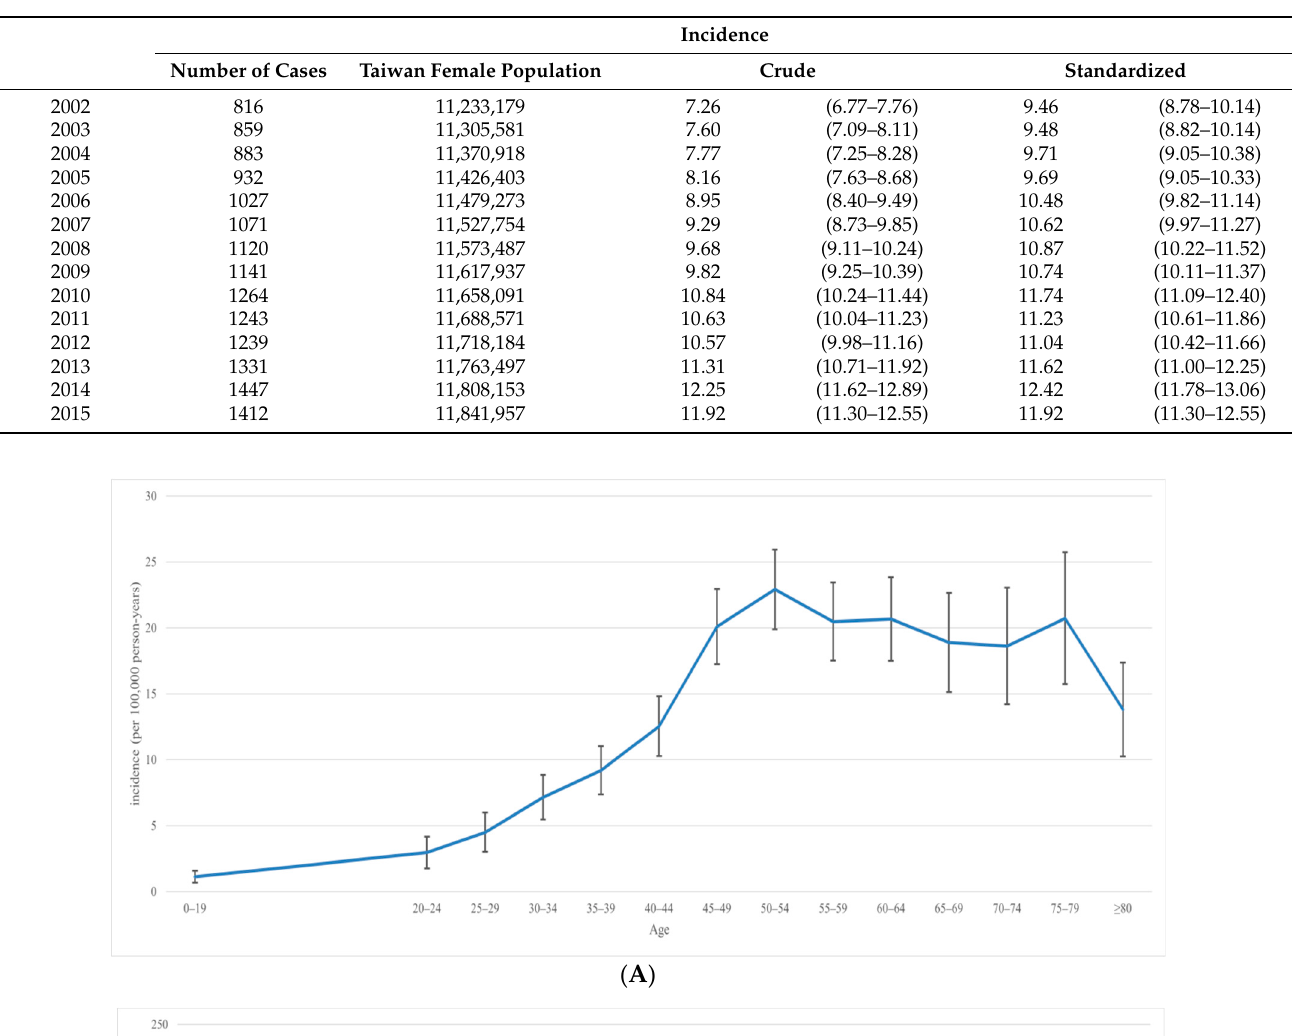
Table 3. Crude and age-standardized incidence (per 100,000 person-years) of ovarian cancer in Taiwan from 2002 to 2015.